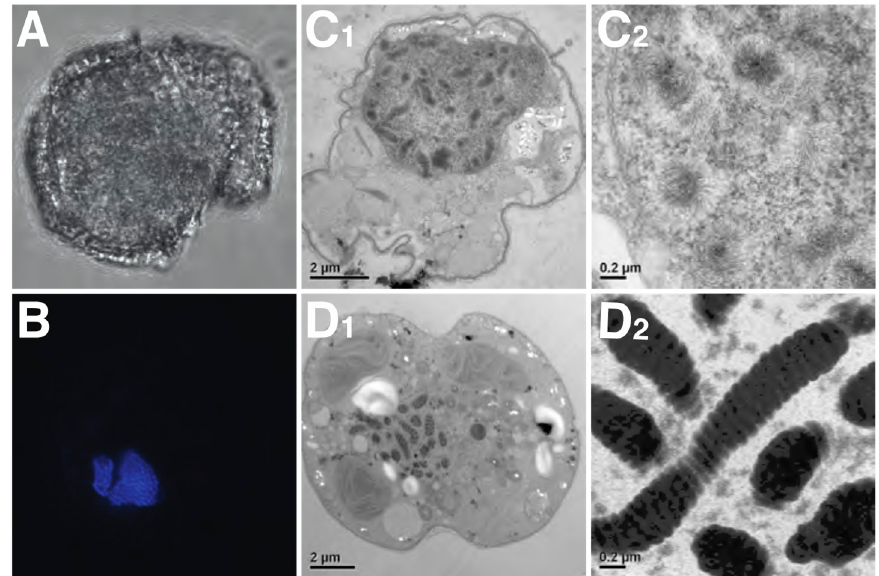
Figure 4. Unusual dinoflagellate chromosome structure. ( A ) Brightfield picture of a formaldehyde–fixed Karlodinium veneficum cell. ( B ) Nucleus of above cell stained with DAPI; note the high number and condensed appearance of the chromosomes. ( C 1 ) Electron micrograph of a section of K. veneficum cell fixed with glutaraldehyde and stained with osmium tetroxide. Chromosomes have a fluffy, cotton candy-like appearance ( C 2 ). ( D 1 ) A cell from the same culture but high-pressure frozen and freeze substituted with osmium instead. Chromosomes are highly electron dense and compact with a banded pattern ( D 2 ). The differences in appearance of the nuclei and chromosomes in ( C 1 , C 2 ) and ( D 1 , D 2 ) highlight how diverse fixation protocols produce very disparate results and that interpretation based solely on such pictures is likely not informative.